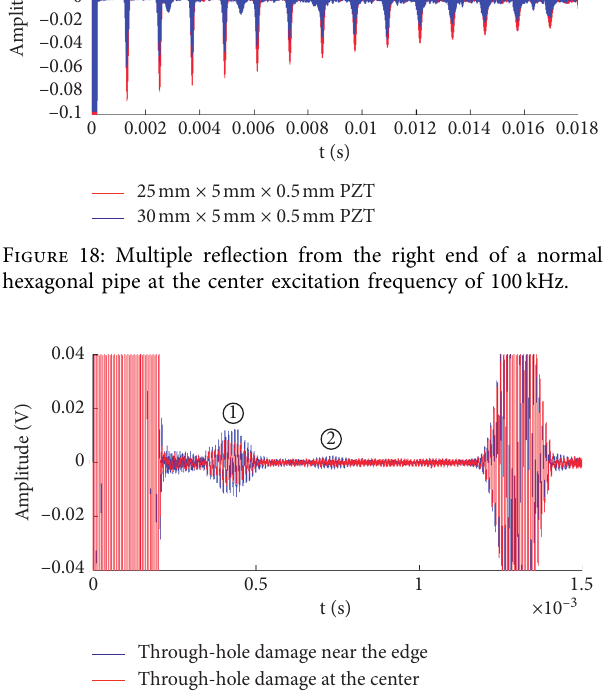
Figure 19: Temporal waveforms received from two damaged hexagonal pipes, one with a circular through-hole damage located at the center of the top surface and the other with the same damage located near the edge of the top surface.